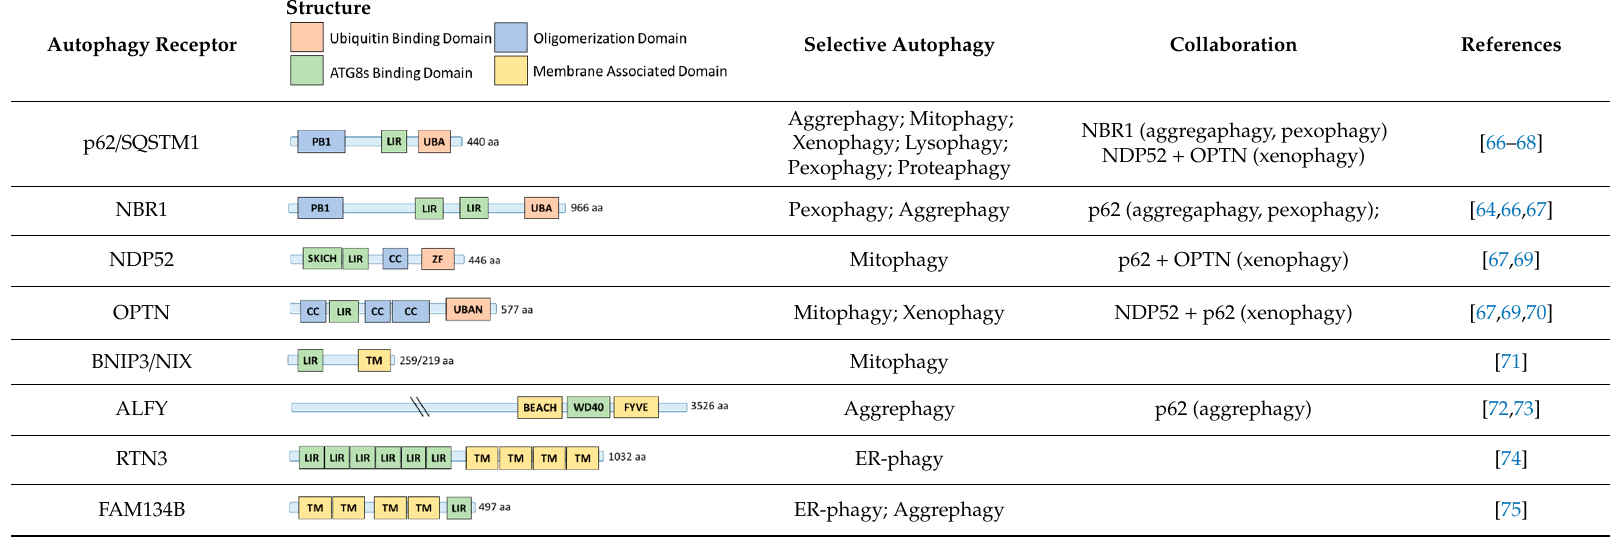
Table 1. Structure and functions associated to the most studied autophagy receptors. Among more than 30 autophagy receptors known so far in mammalians, structural similarities and preserved functional domains are observed such as the presence of ubiquitin binding domains (UBDs), ATG8s binding domains like LC3 interacting regions (LIRs), oligomerization domains like PB1, or membrane associated domain [65]. Involvement of the displayed autophagy receptors in distinct selective autophagy events and collaborations between them are listed.